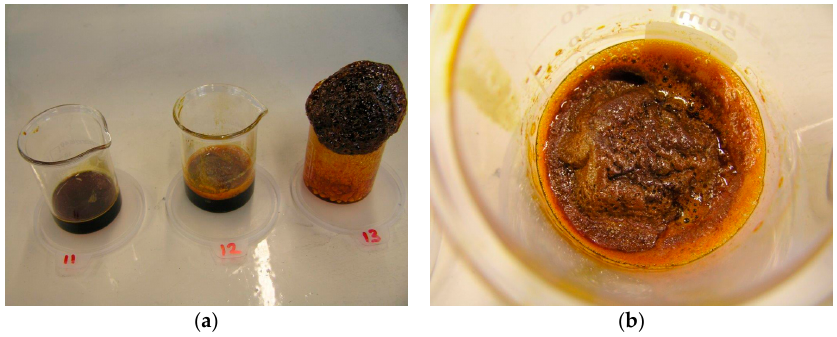
Figure 11. Photo-irradiated Fe(NO 3 ) 3 in silica dispersion after 70 h in a beaker or in a watch glass. ( a ) In a beaker when [Fe]/[Si] = 1/3 (No. 13); 1/2 (No. 12) and 1/1 (No.11); ( b ) In a watch glass when [Fe]/[Si] =